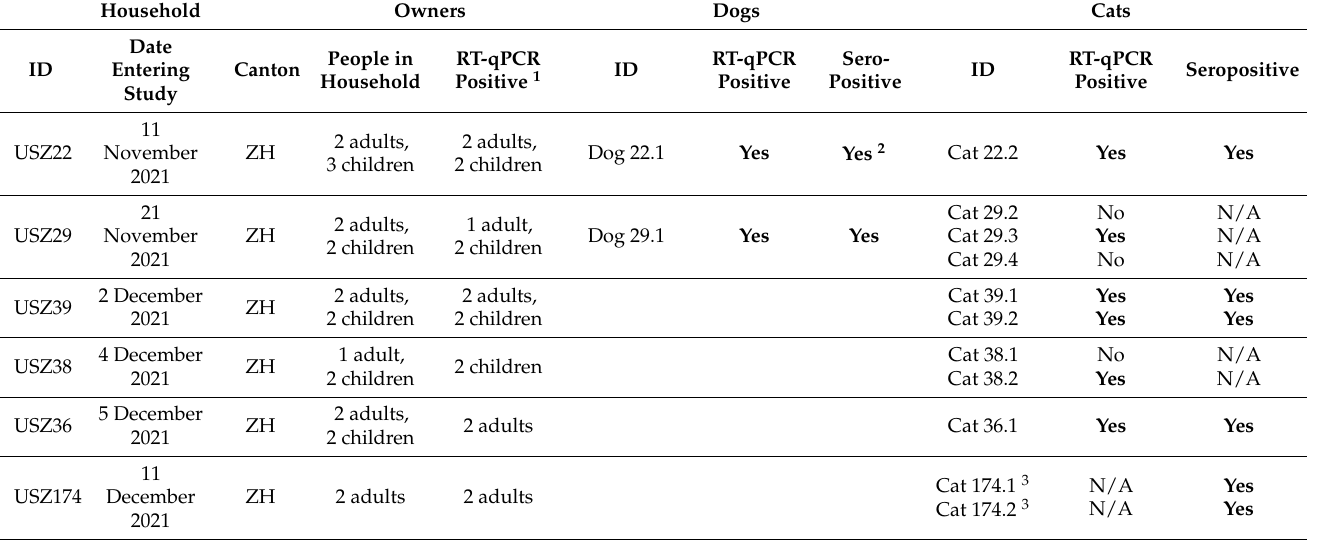
Table 1. Overview of COVID-19-affected households, date of first RT-qPCR test results, number of infected owners and animals, and their RT-qPCR and serological